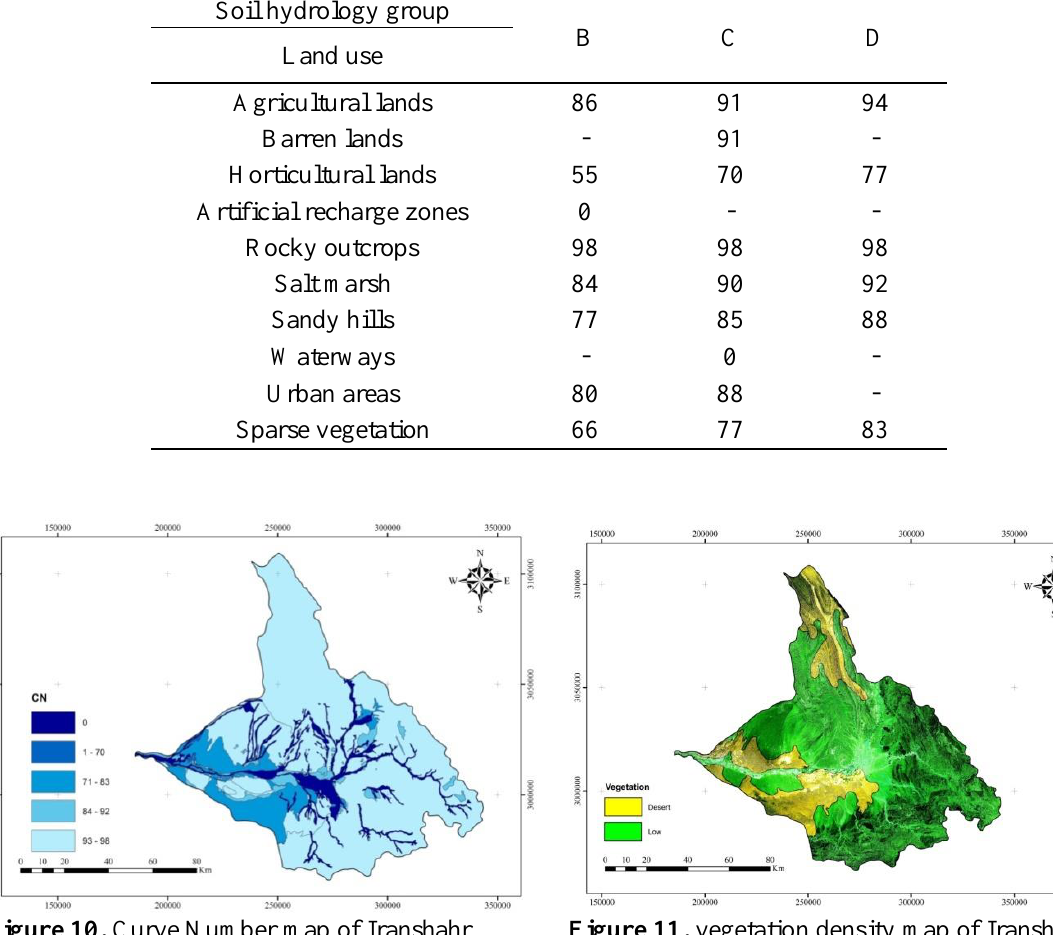
Table 2. Curve Numbers selected with respect to hydrologic soil group, land use and vegetation density of Iranshahr catchment